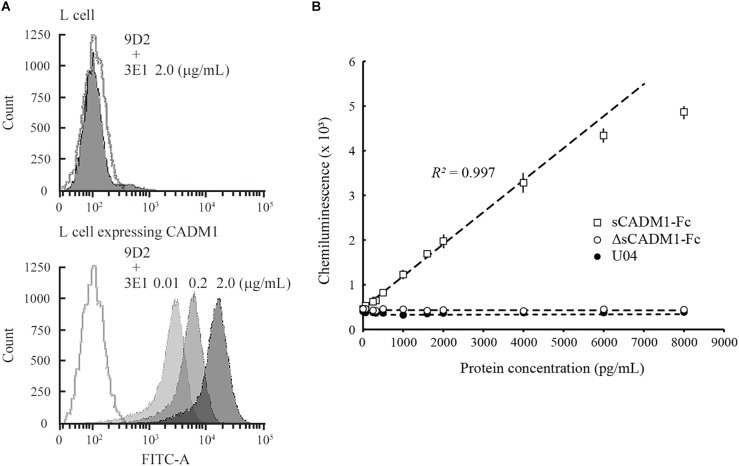
Development of a sandwich ELISA for cell adhesion molecule 1 (CADM1). (A) Fluorescence-activated cell sorting (FACS) analysis of L cells expressing full-length CADM1 using 3E1 and 9D2 antibodies. Original L (upper) or CADM1-expressing L cells (lower) were incubated serially, first with 9D2 and then with 3E1 (0.01, 0.2, or 2 μg/mL; bright to dark gray-painted), or incubated in buffer without any primary antibodies (gray-lined, open), and were then analyzed using FACS. (B) Calibration curve of the CADM1 enzyme-linked immunosorbent assay (ELISA) for sCADM1-Fc. The ELISA was developed using 9D2 and biotinylated 3E1 antibodies as capture and detection antibodies, respectively. Chemiluminescence intensities were measured for recombinant proteins sCADM1-Fc and ΔsCADM1-Fc, and U04 chicken IgY using the ELISA, were shown as dots with bars indicating the SDs, and were then plotted with concentrations determined using the Bradford assay and serially diluted. Note that most of the SDs are too small to be shown in the graph. Representative results are displayed, with the approximate line and curve (dotted lines). Pearson’s R2 corresponding to the linear approximation for sCADM1-Fc is shown (range: 0–4,000 pg/mL).